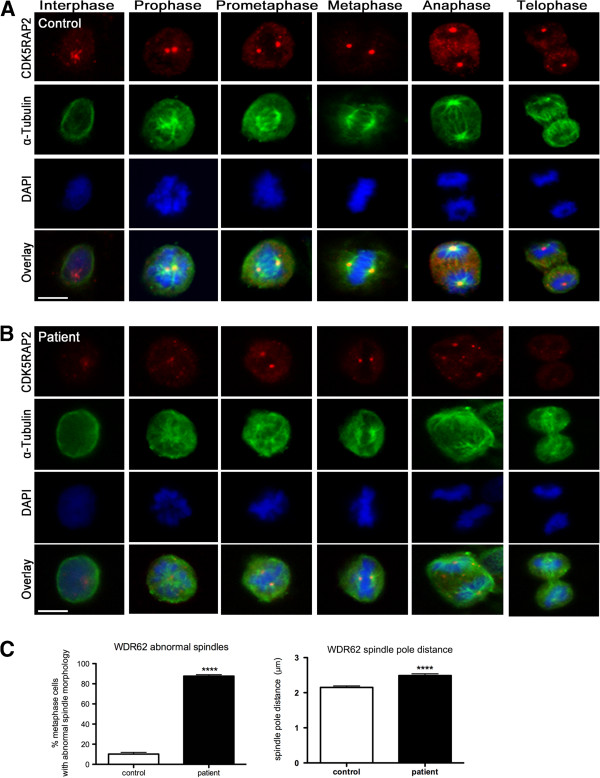
Spindle defects in WDR62 mutant patient cells. Subcellular localization of CDK5RAP2 and α-tubulin throughout the cell cycle in immortalized lymphocytes of (A) control and (B) MCPH2 patient. While the spindle apparatus has a regular bipolar form of appearance from prometaphase to telophase in controls, patient cells show abnormal spindle formation with an increase of abnormal misdirected spindles and broad, unfocused microtubules poles. CDK5RAP2 signals are weaker in patient’s cells than in controls. Cells were stained for CDK5RAP2 (red), for α-tubulin (green), and for DNA using DAPI (blue). (C) Quantification results of abnormal spindles and spindle pole distance (n = 115 metaphase lymphoblastoid cells, p < 0.0001, Student’s t-test).